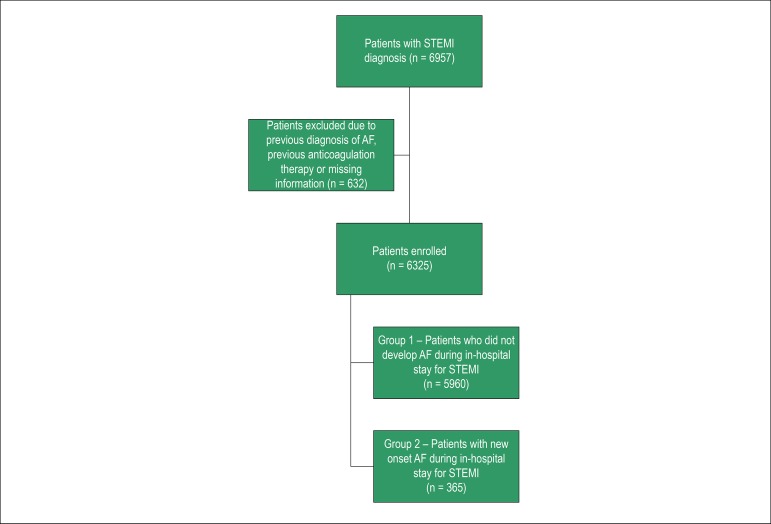
Flowchart with patients included and excluded.